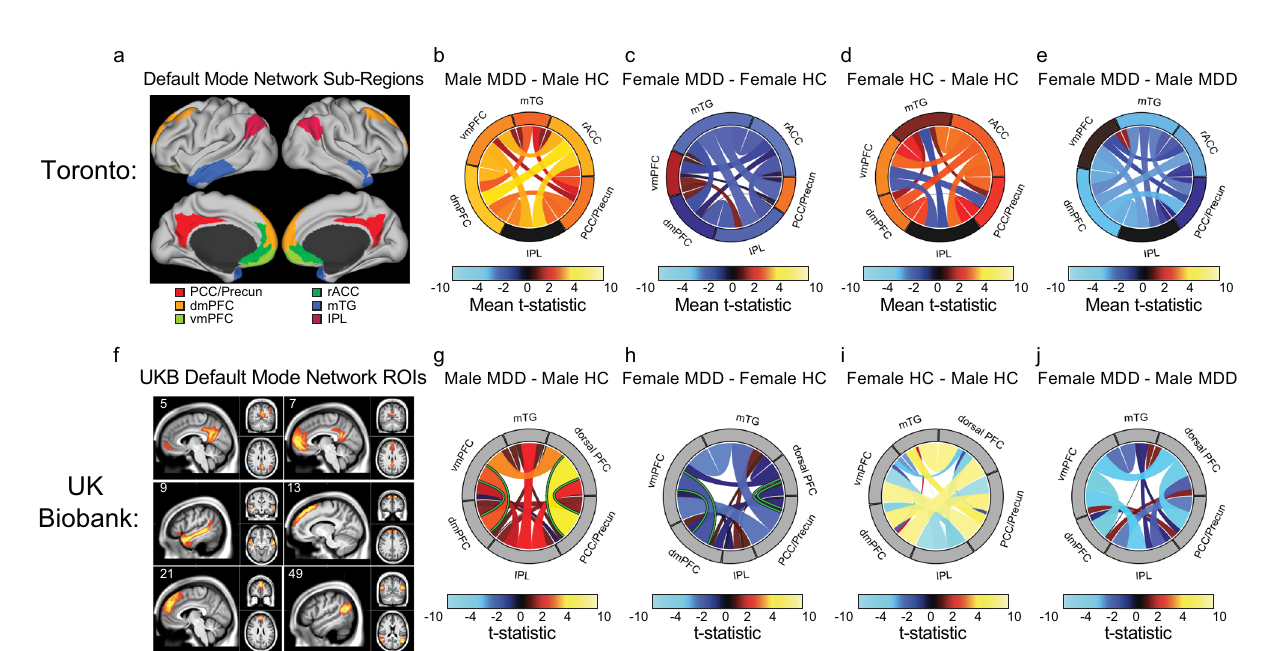
Fig. 1 | Shared and sex-speci fi c rsFC abnormalities in a depression-related network. a , b Color maps representing the neuroanatomical distribution of sig- ni fi cant (FDR q <0.05) F-statisticsfrom 2-wayANOVA for rsFCfeatures connecting 77 default mode network (DMN) nodes and the rest of the brain in n =371 patients withmajordepressivedisorder(MDD)( n =223women)vs. n =182healthycontrols ( n =103 women). The neuroanatomical distribution of signi fi cant main effects of MDD ( a ) and MDD-by-sex interactions ( b ) are summarized for each functional parcel by summing across the signi fi cant effectsin the 77 DMN nodes and plotting the result on a brain surface and accompanying subcortical image. c , d Summary t-statisticsfromposthoct-testscomparingmale( c )andfemale( d )MDDpatientsvs. healthy controls, summarized by grouping neuroanatomically adjacent Glasser HCPMM1 parcels within each network. Colors in each tile represent the average t-statistic for all rsFC features in a given region that exceed a threshold of p <0.05 uncorrected. Positive t-statistics denote increased rsFC in MDD. Regions with at ANOVA depicted in ( a , b ) are demarcated with an asterisk. e – g Color maps